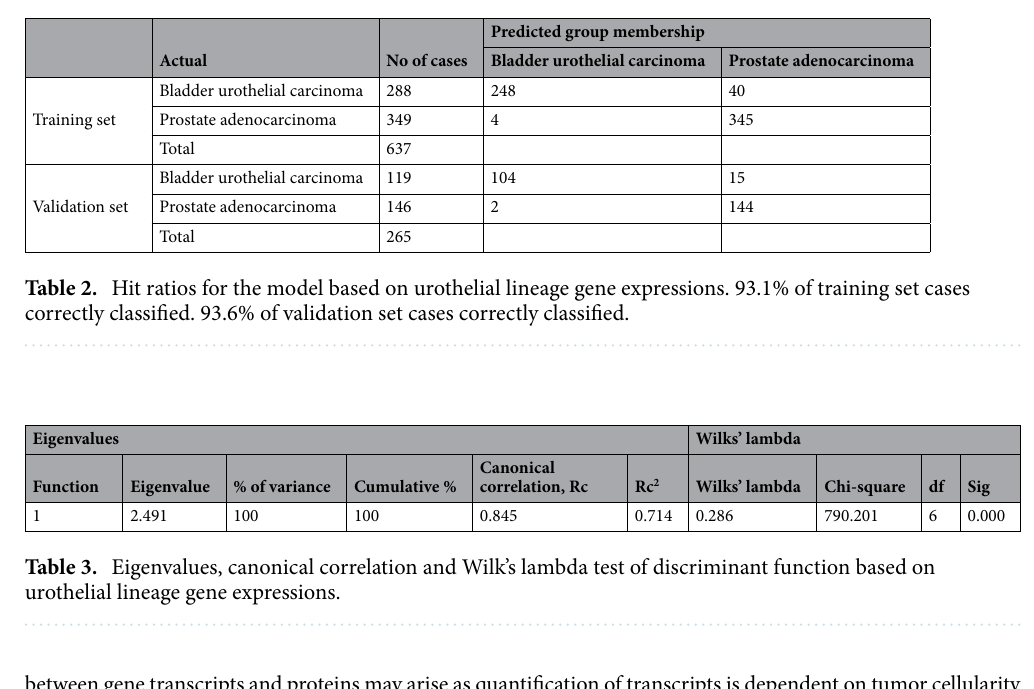
Table 3. Eigenvalues, canonical correlation and Wilk’s lambda test of discriminant function based on urothelial lineage gene expressions.